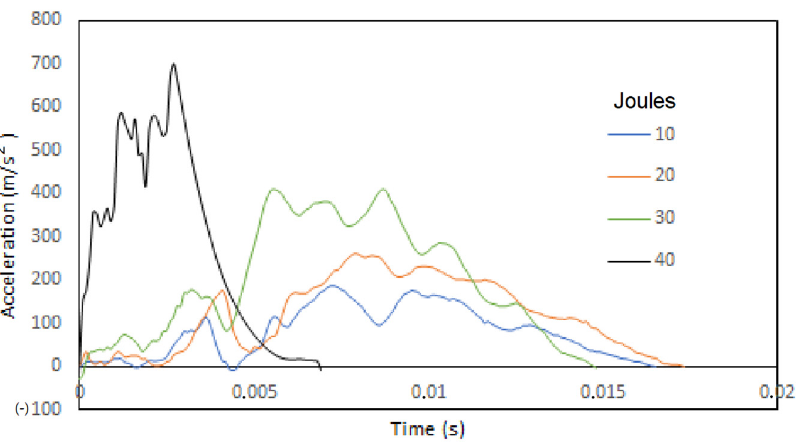
Figure 12. Acceleration profile (m/s 2 ) of the panels during deformation for impacts of 10, 20, 30 and 40 joules.